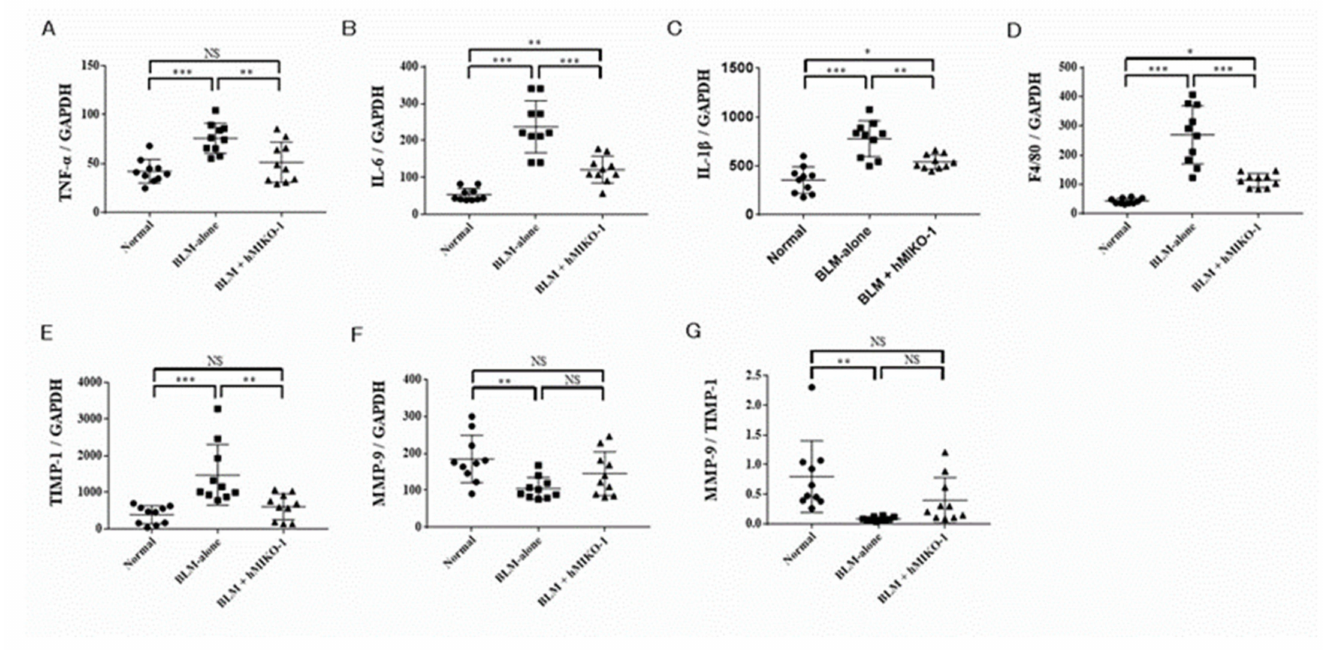
Figure 2. Quantitative reverse transcription-PCR analysis of lung mRNA expression. Relative mRNA expression of TNF- α ( A ), IL-6 ( B ), IL-1 β ( C ), F4/80 ( D ), TIMP-1 ( E ), MMP-9 ( F ), and the MMP- 9/TIMP-1 ratio ( G ) in the lungs of BLM-ILD mice on day 28. Data are shown as mean ± SD (N = 10 mice per group). * p < 0.05, ** p < 0.01, *** p < 0.001, significant differences between the linked groups. NS: not